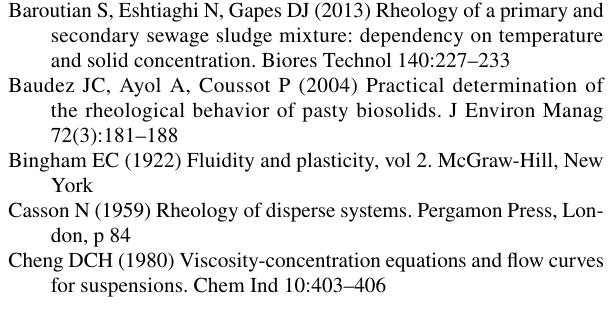
Fig. 9 Rheological data of mud for C model constants calculations. a Power law model fitting ( k = 1.4715; n = 0,2358; R 2 = 0.8703 ). b Herschel–Bulkley model